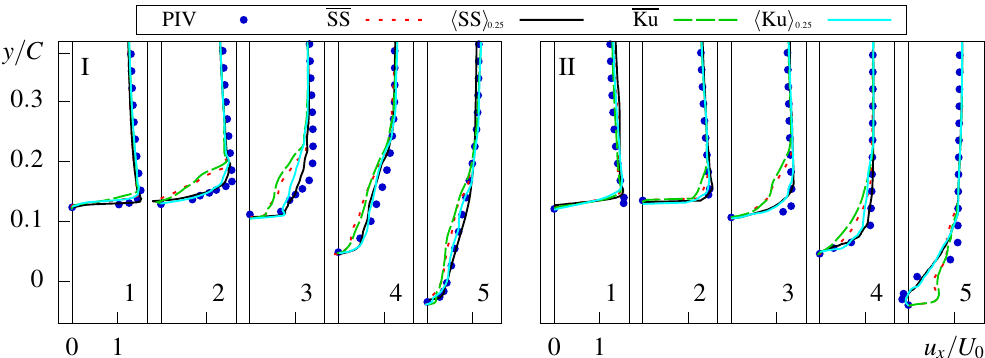
Figure 10. Comparison of experimental and numerical profiles of streamwise component of averaged velocity for regime I ( left ) and II ( right ) in cross-sections depicted in Figure 2 at hydrofoil midspan. Results of Schnerr–Sauer (SS) and Kunz (Ku) models with LUDS discretization scheme for convective term in momentum equation are both presented for time-averaging ( . ) and conditional averaging . procedures according to Equation (21). The threshold value of ˜ α th is chosen to be (cid:104) (cid:105) ˜ α th equal to